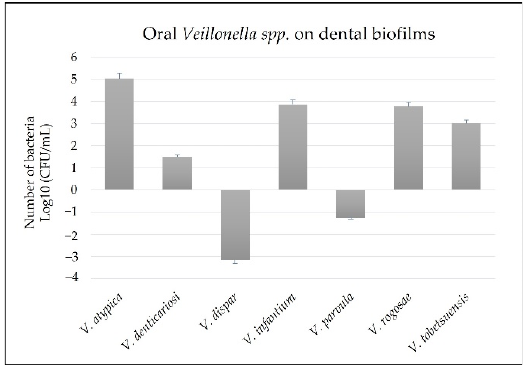
Figure 2. Number of oral Veillonella species on dental biofilms.